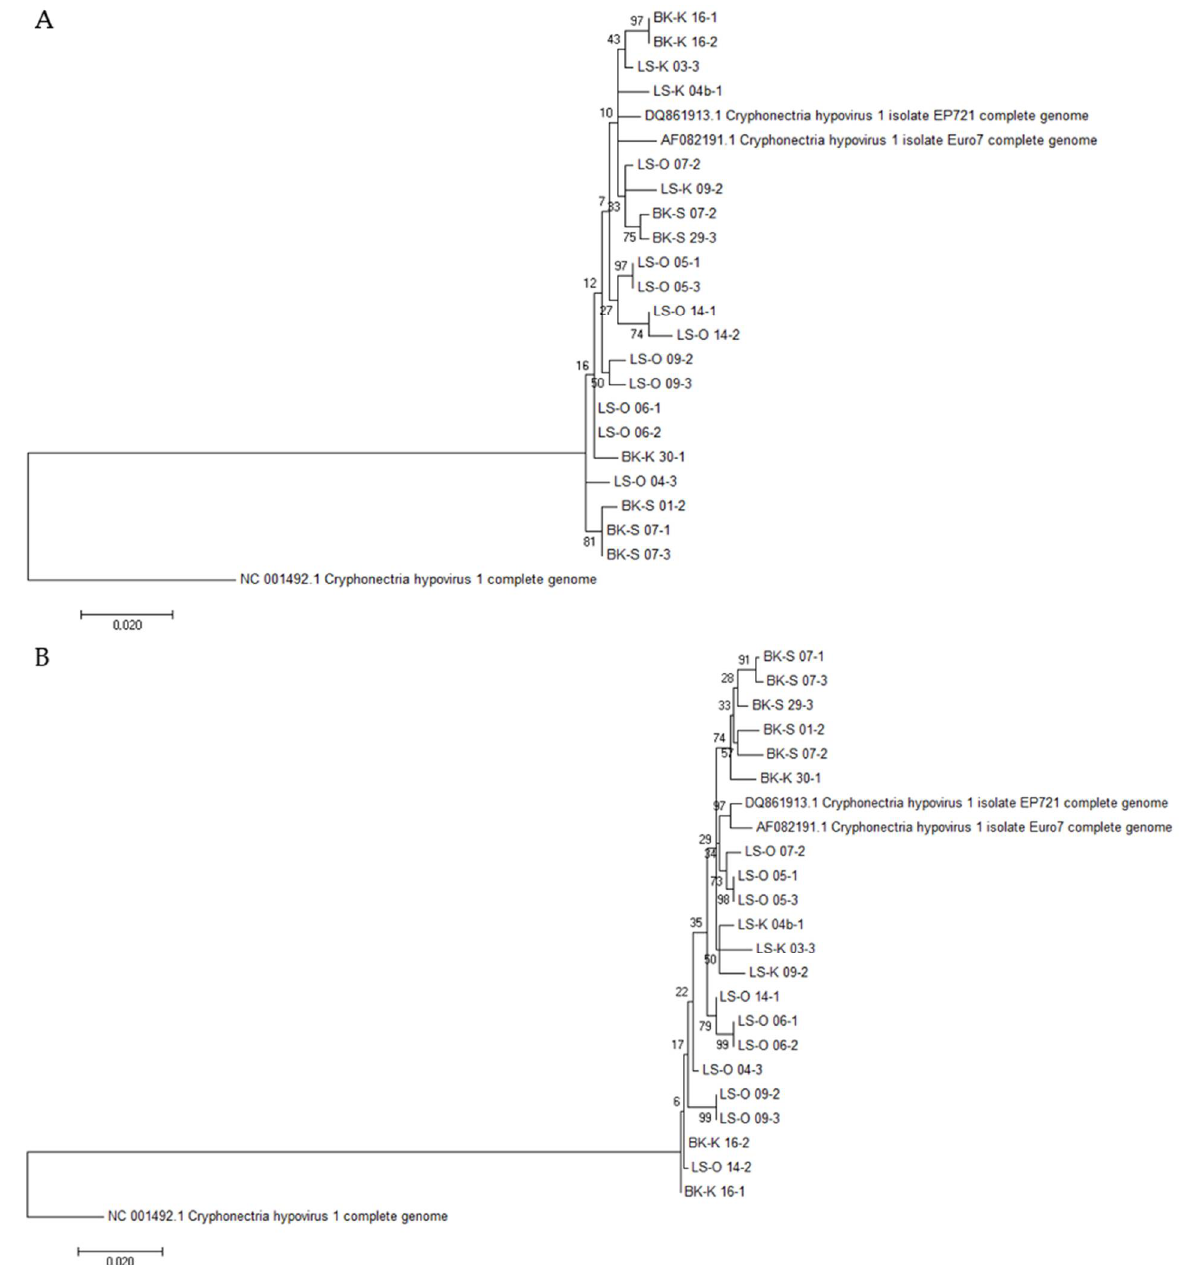
Figure 2. Phylogenetic tree of Cryphonectria hypovirus 1 (CHV1) sequences from Montenegro con- structed with maximum likelihood method. Figure in ( A ) is inferred from 609 nt long part of ORF-A, and in ( B ) from 1199 nt long part of ORF-B. Reference CHV1 sequences Euro7 (accession number AF082191) and EP721 (accession number DQ861913) were also included in the analysis, and EP713 (accession number NC_001492) was used as the root of the tree. All reference sequences have been truncated to the same region as analyzed sequences. Bootstrap values of 1000 replicates are indicated on branches.